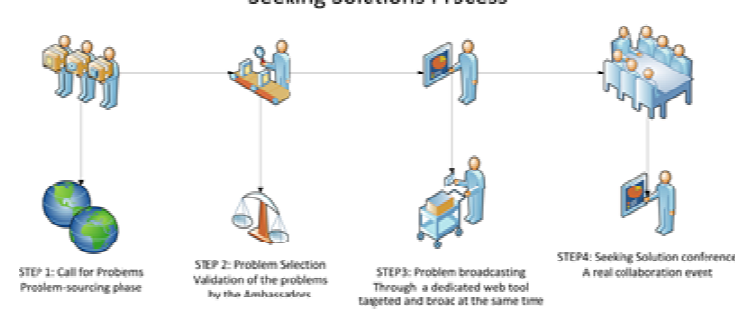
Fig. 1. The Seeking solutions